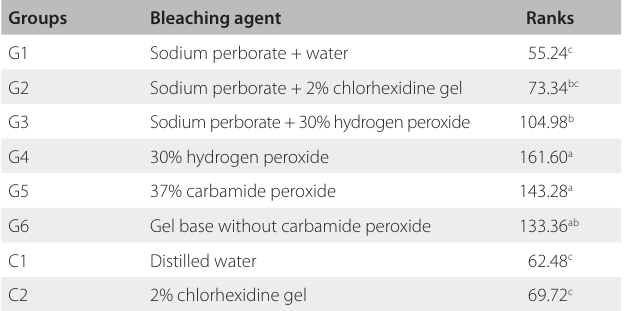
Table 1. Dentin surface morphological changes caused by different bleaching agents Groups